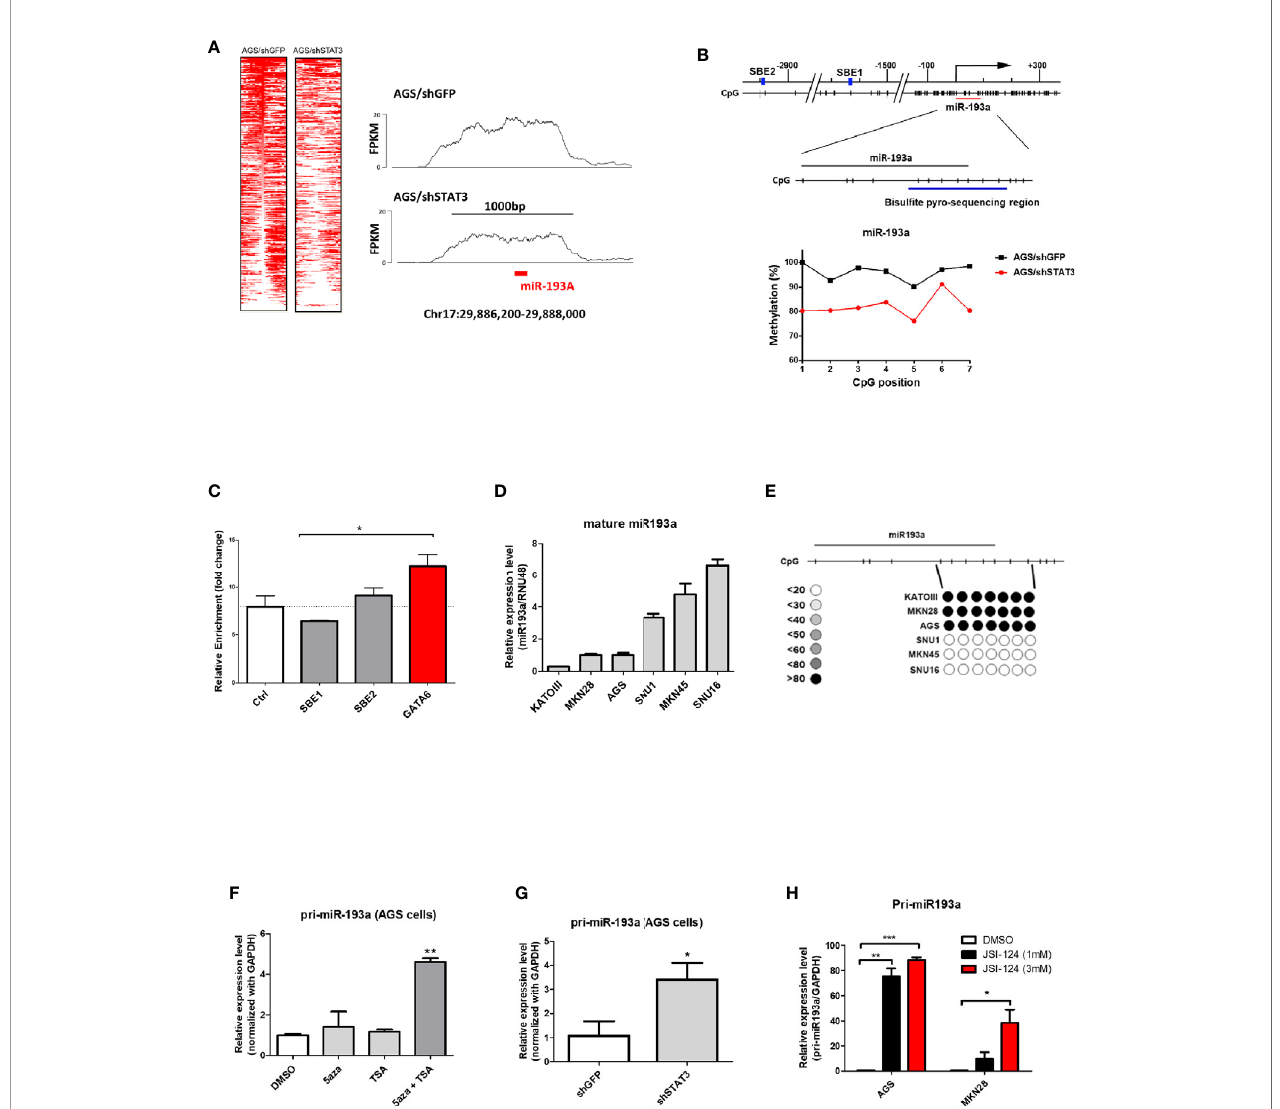
FIGURE 1 | Identi fi cation of miR-193a as a STAT3-mediated hypermethylated target in gastric cancer cells. AGS gastric cancer cells infected with lentivirus expression control (AGS/shGFP) or shRNA against STAT3 (AGS/shSTAT3) were used to perform methylation and expression analysis. (A) Global methylation analysis of the parental AGS/shGFP or AGS/shSTAT3, by MBDcap-Seq. Left panel, heatmap showing differential methylated regions (DMR) in AGS/shSTA3 and AGS/shGFP cells. Right panel, representative histogram showing methylation level of chromosome region around miR-193a (chr17:29886200-29888000) in AGS control and STAT3 depleted cells. (B) Bisul fi te sequencing of miR-193a methylation in AGS control and STAT3 depleted cells. Upper panel, schematic diagram showing the genomic map of miR-193a promoter, with the corresponding locations of CpG sites and the putative STAT3 binding site (SBE, blue box). The location of miR-193a (red line) and region for bisul fi te pyrosequencing analysis (enlarged region) is also shown. Lower panel, scatter plot showing the methylation level of the seven CpG sites being interrogated in AGS control (AGS/shGFP) and STAT3 depleted cells (AGS/shSTAT3). (C) ChIP-PCR showing the binding of STAT3 to SBE1, SBE2 of the promoter region of miR-193a. Negative control region (Ctrl, -400 upstream of TSS) and positive control (GATA6) were also shown. Relative expression and methylation level of mature miR-193a in a panel of gastric cancer cell lines was also determined by (D) quantitative RT-PCR and (E) bisul fi te pyrosequencing. Relative expression level of miR-193a in AGS cells treated with (F) epigenetic modi fi ers (DNMT inhibitor, 5aza, and/or HDAC inhibitor, TSA), (G) shRNA against STAT3 (shSTAT3), or (H) a speci fi c STAT3 inhibitor (JSI-124). Each bar represents mean ± SD of duplicate experiments (*p < 0.05, **p < 0.01; ***p <